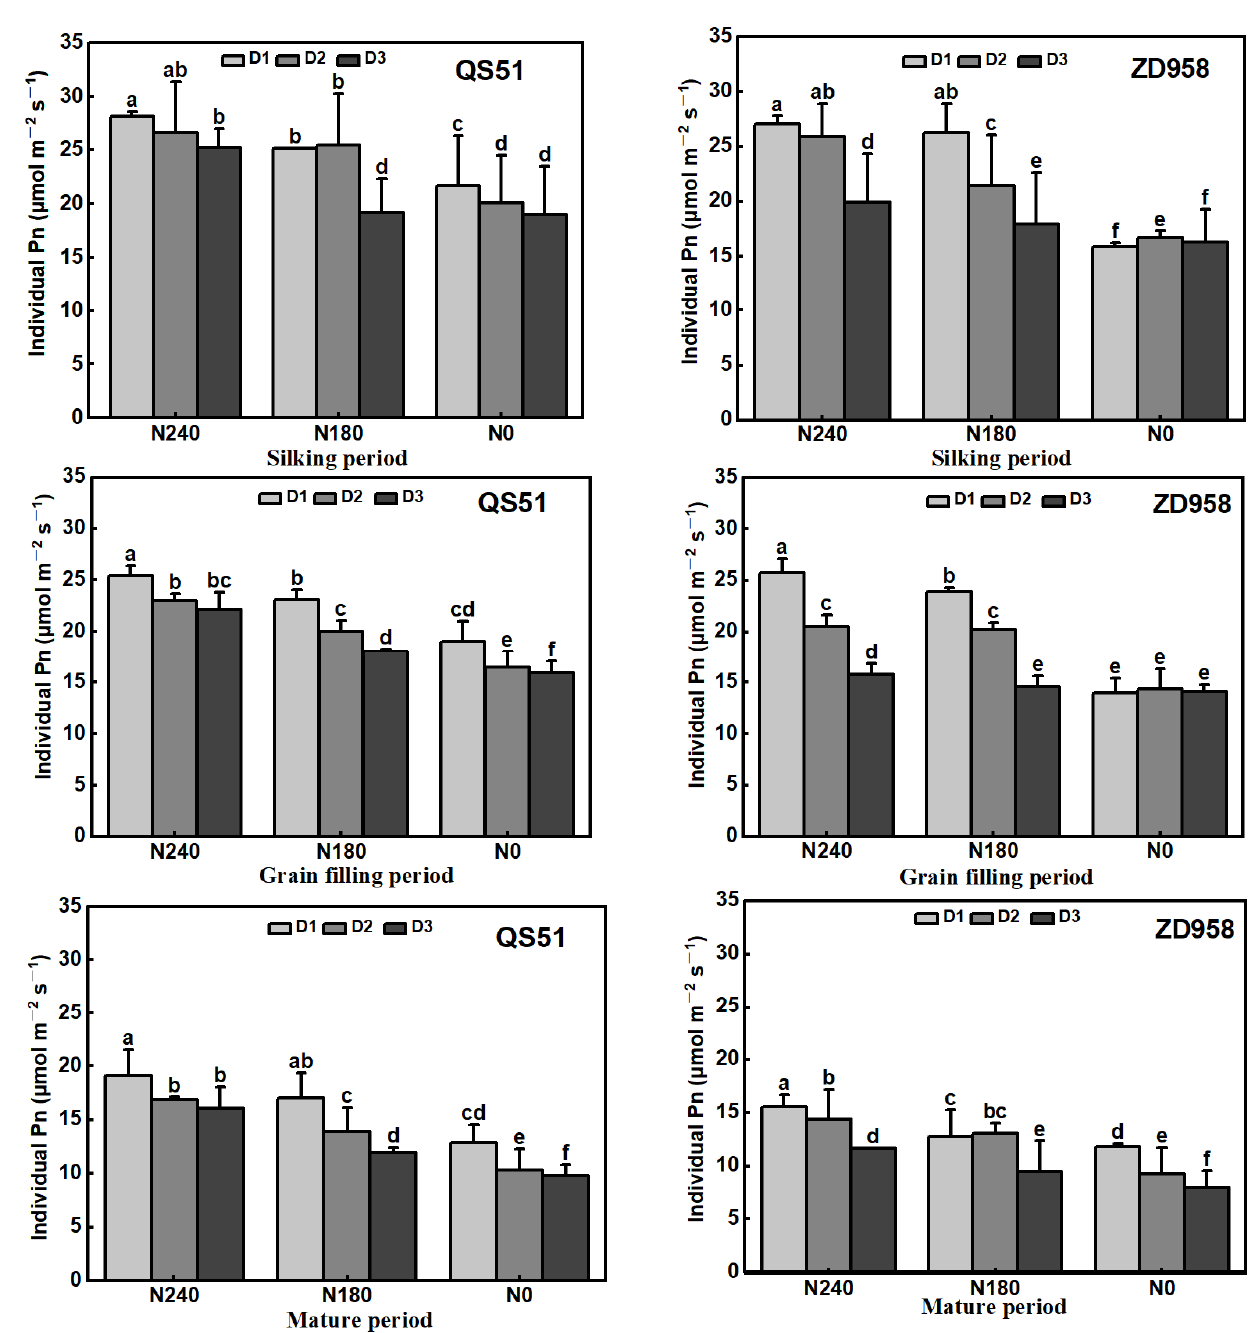
Figure 3. Effects of planting density and nitrogen (N) rate on individual photosynthetic rate ( P n ) of maize at different growth stages. D1: 80,000 plants ha − 1 ; D2: 100,000 plants ha − 1 ; D3: 120,000 plants ha − 1 ; N0: no N application; N180: 180 kg N ha − 1 ; N240: 240 kg N ha − 1 . Bars are the means ± standard